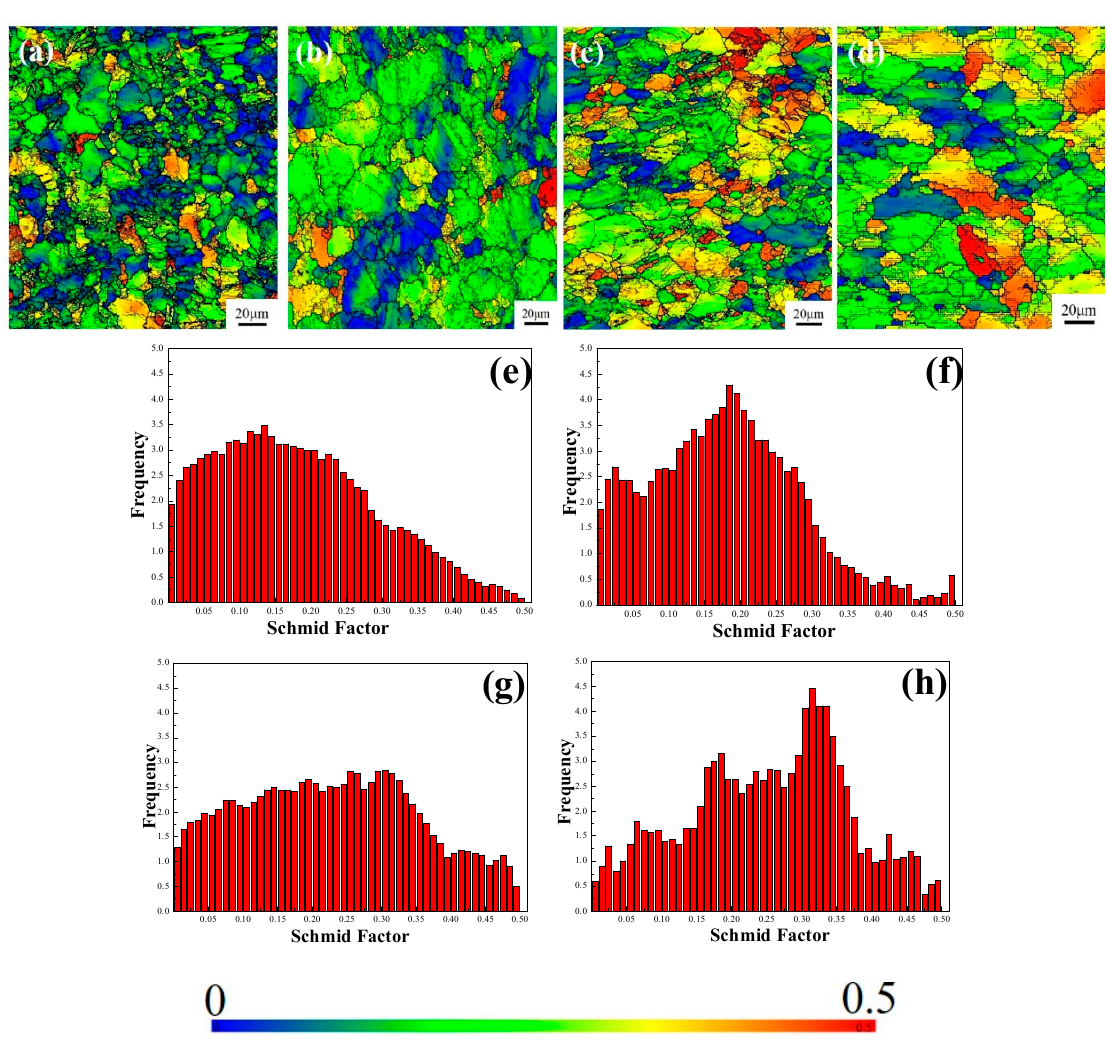
Figure 7. The (0002) basal plane slip Schmid Factor distribution microgram ( a – d ) and corresponding Schmid Factor distribution histogram ( e – h ): ( a , e ) pre-aged for 75 min; ( b , f ) pre-aged for 160 min; ( c , g ) pre-aged for 200 min and ( d , h ) pre-aged for 240 min.